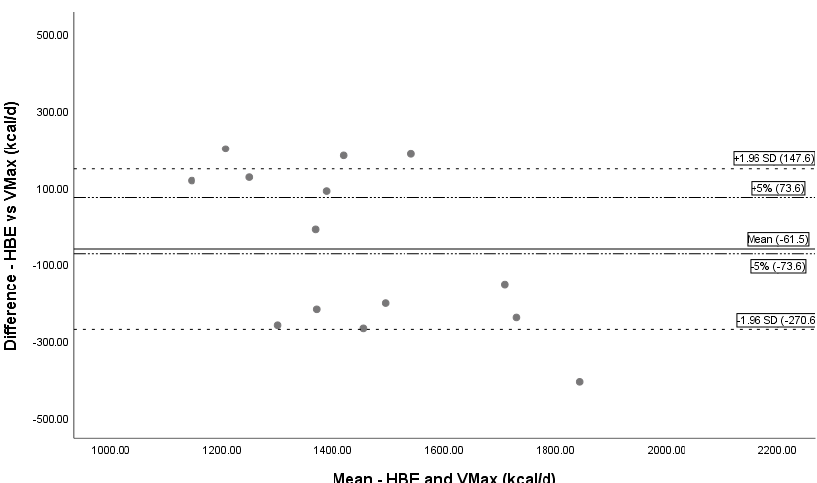
Figure 5. Bland–Altman Plot HBE and Vmax. Bland–Altman plot showing the mean bias and limits of agreement between Vmax and HBE. The solid line represents mean bias ( − 61.5 kcal/day), a systematic underprediction of REE by HBE. Dashed lines represent confidence intervals (± 1.96 SD). Dotted and dashed lines are a reference line for ±5% difference. Abbreviations: REE = resting energy expenditure; HBE = Harris Benedict equation, d = day.